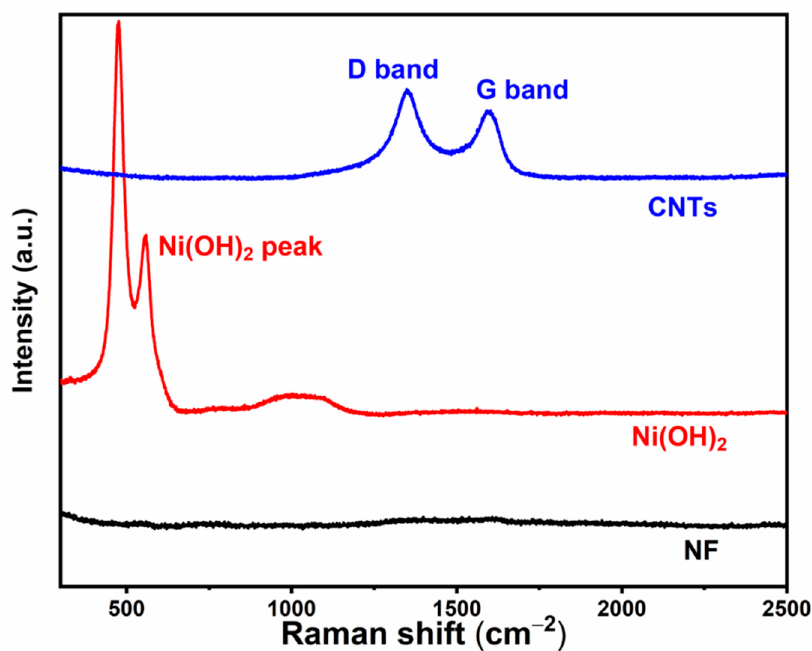
Figure 4. Raman spectrum of Ni(OH) 2 thin film converted via the CV method (red line), and CNTs grown by the CVD process (blue line).